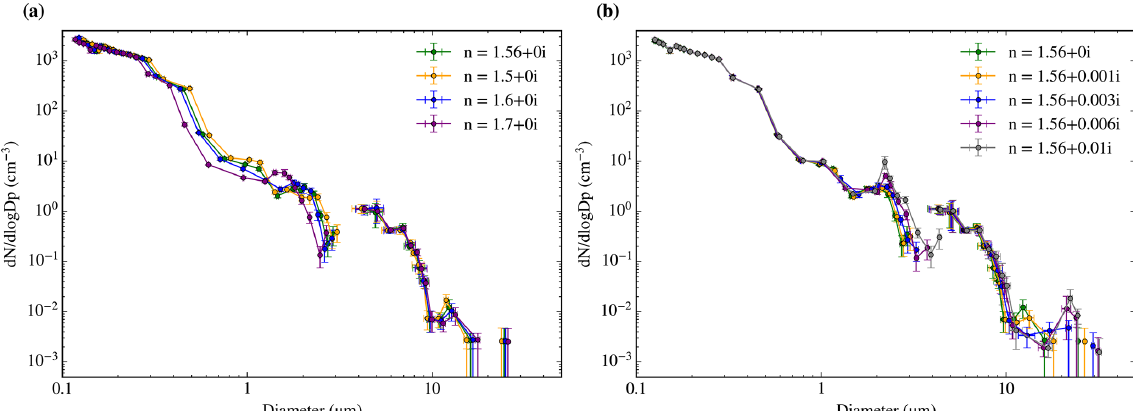
Figure 5. Sensitivity of the size distributions measured by the PCASP–CDP during the C010 flight on 10 May 2017 from 11:24 to 11:38UTC to small variations in the refractive index. We tested both the real part (a) and imaginary part (b) . The errors are calculated according to the methods explained in Sect.